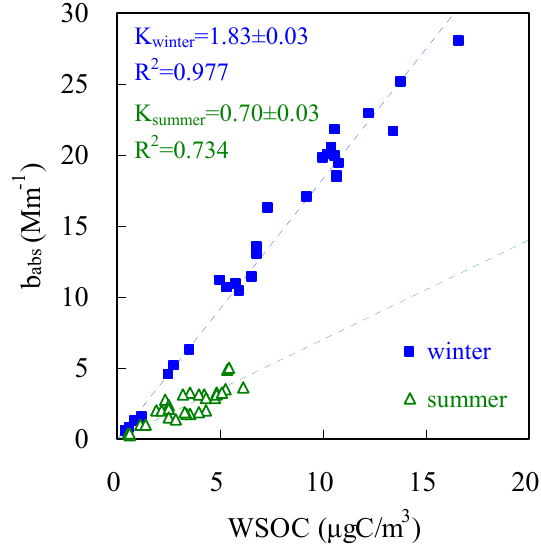
Fig. 6. Dependence of b abs measured at 365nm on the WSOC concentration during winter and summer. Linear regression results are shown with K as the slope (intercept is set as zero).